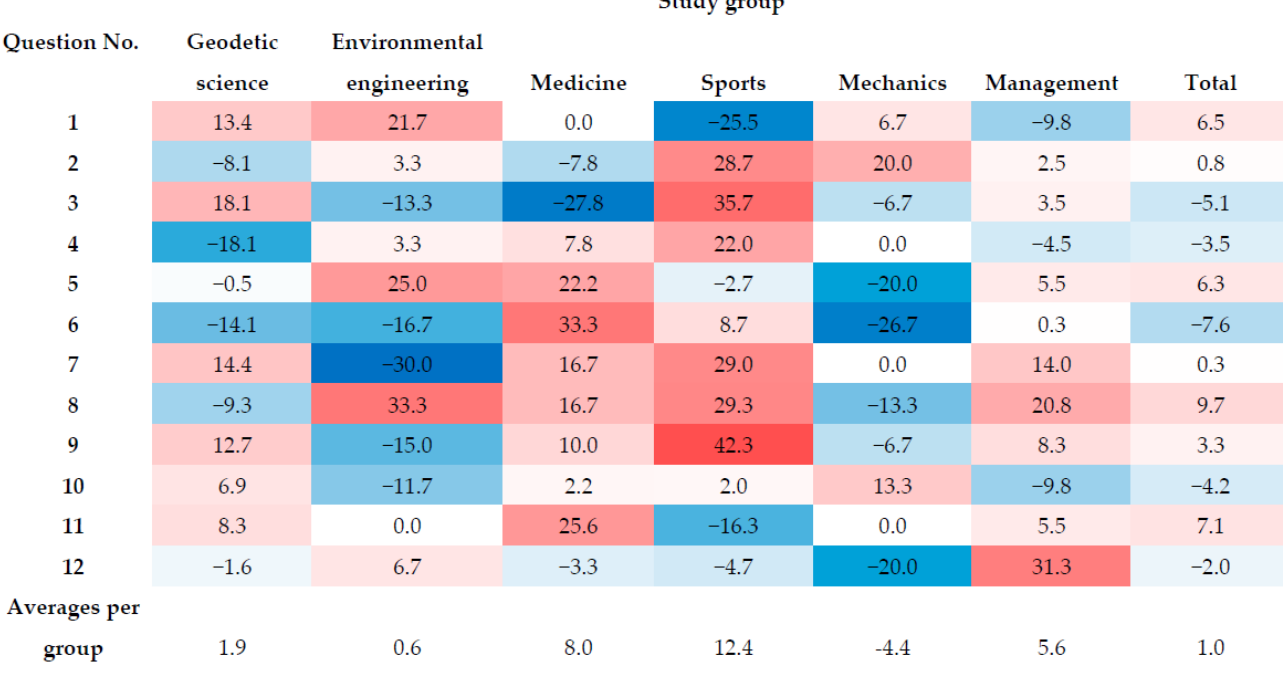
Figure 7. Differences (men-women) between the percentages of correct answers given by men and women to questions 1 – 12 overall and in the study groups, provided in percentage points.